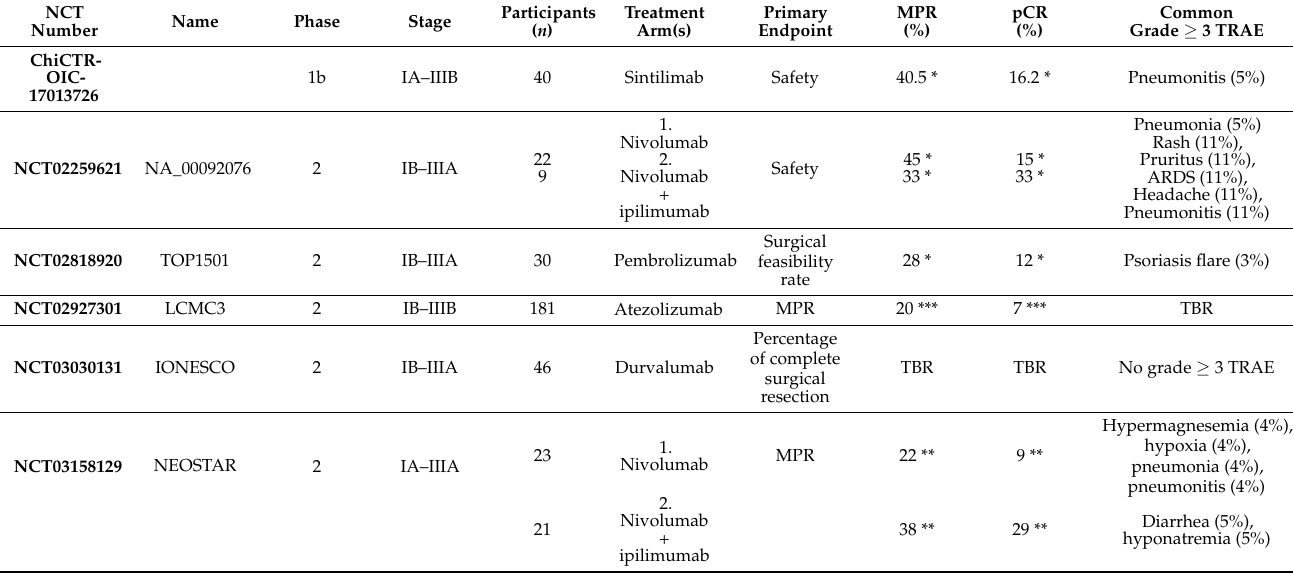
Table 1. Past clinical trials that included neoadjuvant immunotherapy in resectable